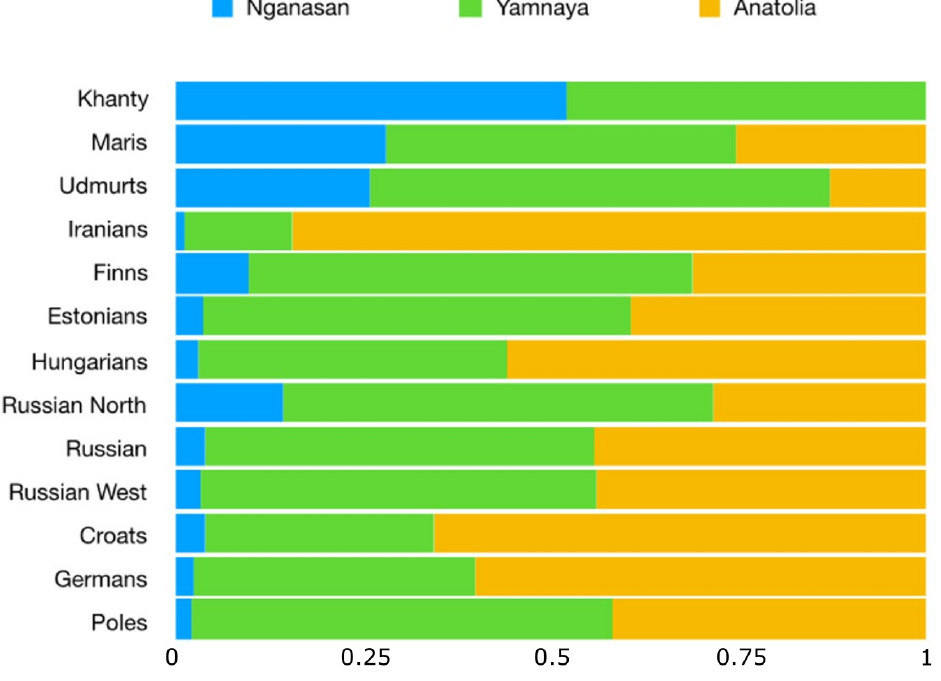
Figure 7. Admixture proportions from three sources estimated using qpAdm. Sources used were Nganasan, Yamnaya and Anatolia (percentages and chi-square values are shown in the Supplementary Table S4).